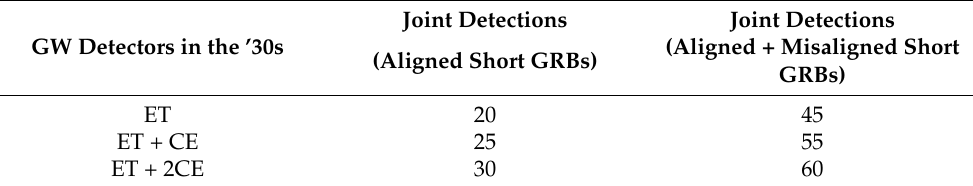
Table 2. Expected joint detections of short GRBs with THESEUS and the 3G GW interferometers (ET = Einstein Telescope, CE = Cosmic Explorer) expected to be operational in the second half of the 2030s, by assuming 3.45 years of joint observations